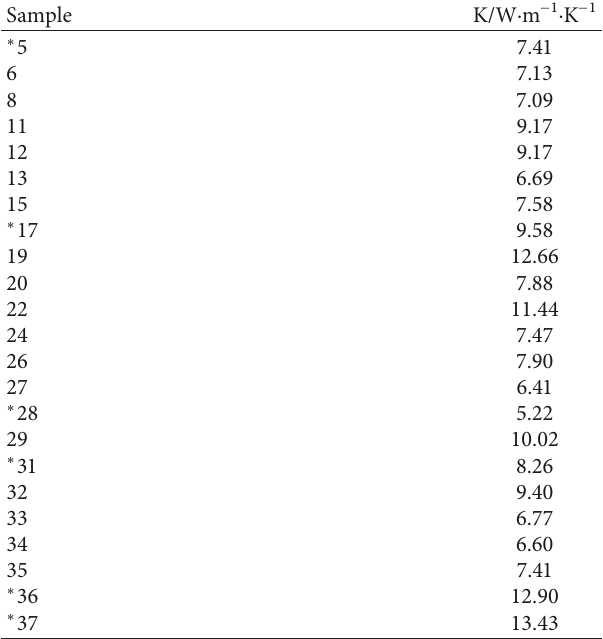
Table 2: Thermal conductivities of the laminates, inferior to the thermal conductivity of sample